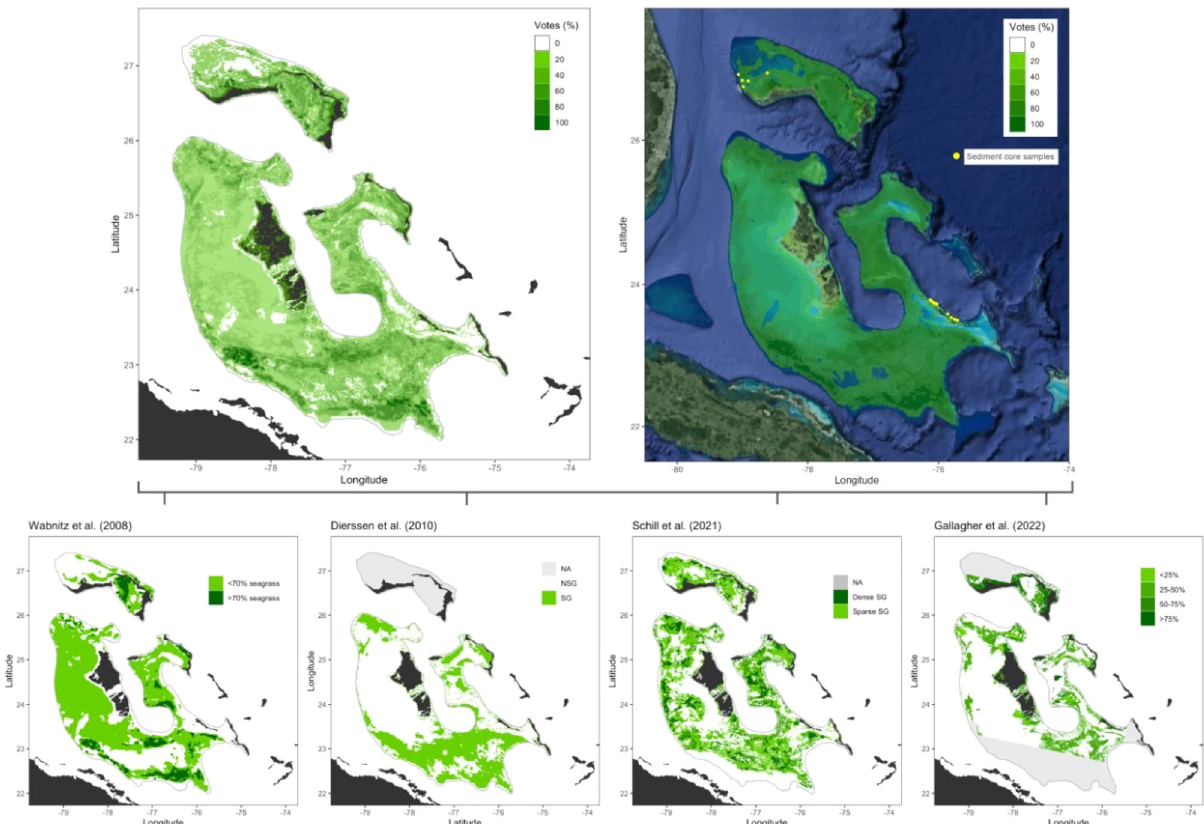
Fig. 1 | Estimates, based on remote sensing, of seagrass cover on The Bahama Banks. Data from existing assessments 18 – 20 and a new assessment derived here (2022; bottom row). Gray regions (NA) indicate areas where no estimates were derived from each remote sensing source (panels in bottom row). Top panels represent aggregated estimates of seagrass coverage from the three sources